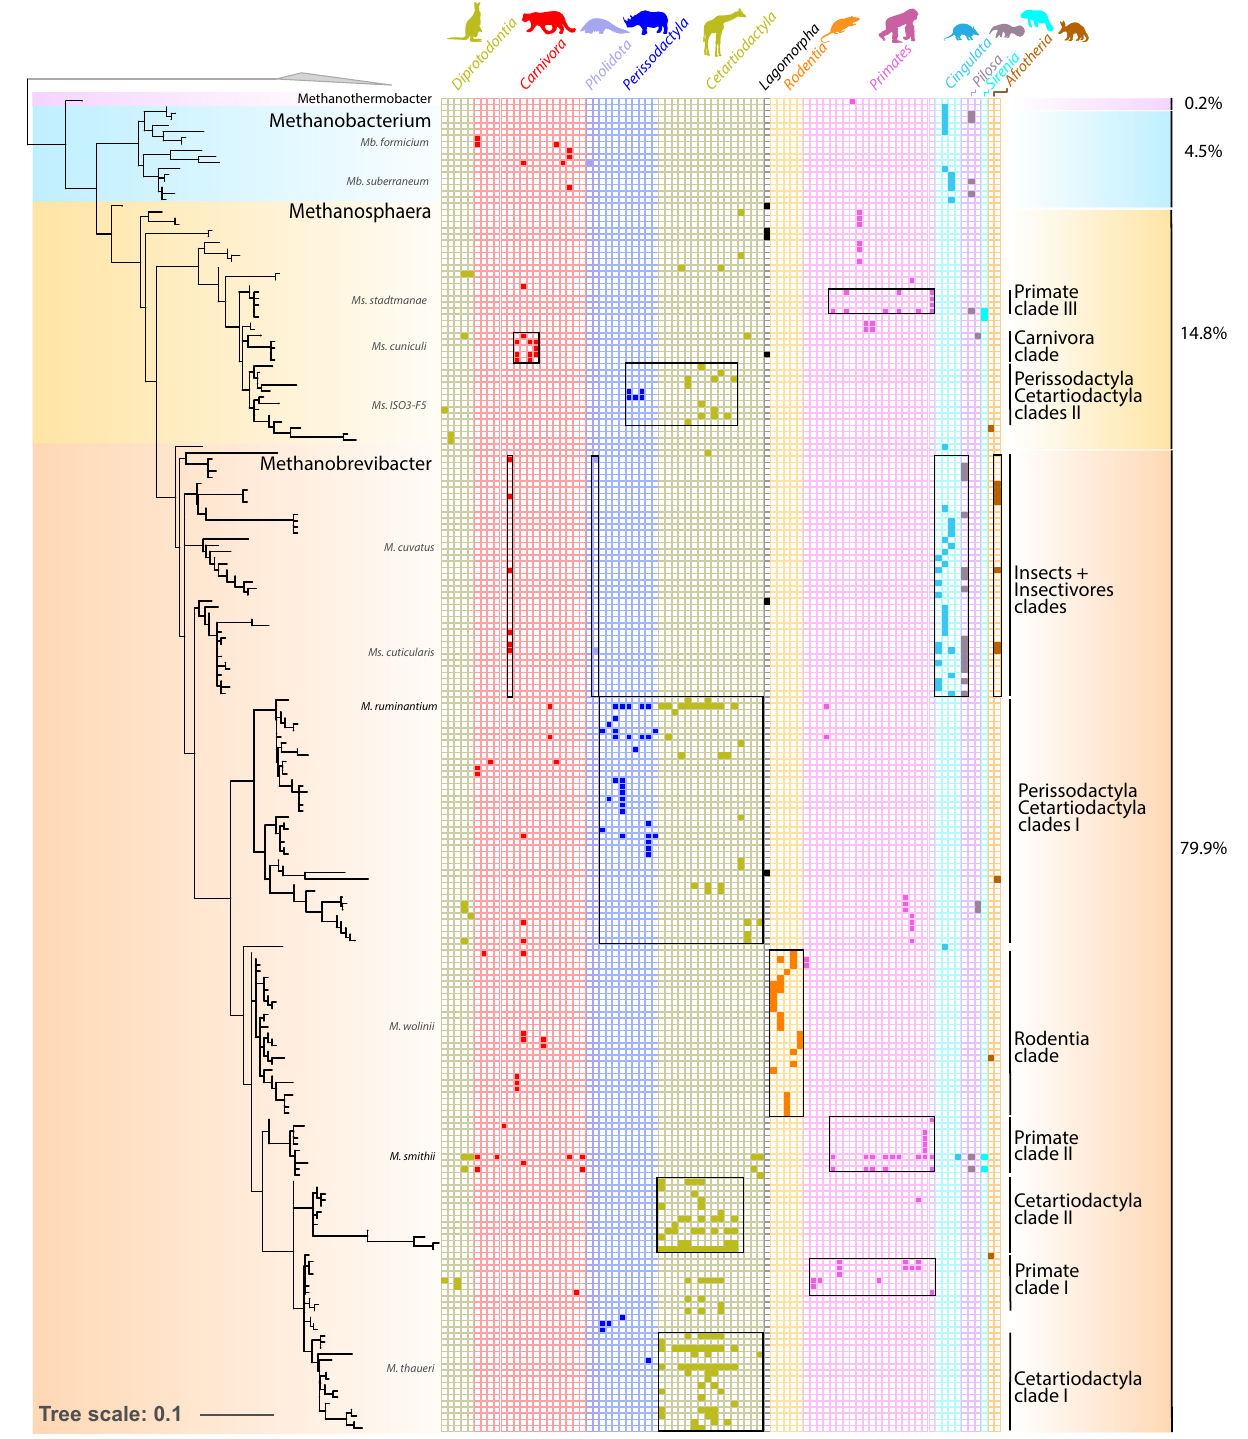
Fig. 4 Distribution of Methanobacteriales ASVs among mammal species. The phylogenetic tree (maximum-likelihood, GTR + G4) of Methanobacteriales was built with nearly full length 16S rRNA genes sequences from literature and the ASVs sequences from this study. For display purposes, the shown tree includes only the ASVs representing more than 1% of the sequences per sample, and no sequence from literature. Presence/absence of ASVs in animals is indicated by coloured highlighted/blank squares. Animal were gathered by mammalian orders, each with a different colour, as indicated on the top. Black boxes highlight archaeal clades preferentially present in a given host order, except for the Insect + insectivores clade composed of archaea preferentially present in insectivorous animals from different mammalian orders and insects (mostly termites, sequences from the literature). Clades corresponding to the boxes are labelled with thick lines on the phylogenetic tree. Species names in front of the tree indicate the position of cultured representatives of the Methanobacteriales. The percentages on the right indicate the proportion of reads from Methanobacteriales that were annotated as Methanobrevibacter (orange background), Methanosphaera (yellow background), Methanobacterium (blue background) and Methanothermobacter (pink